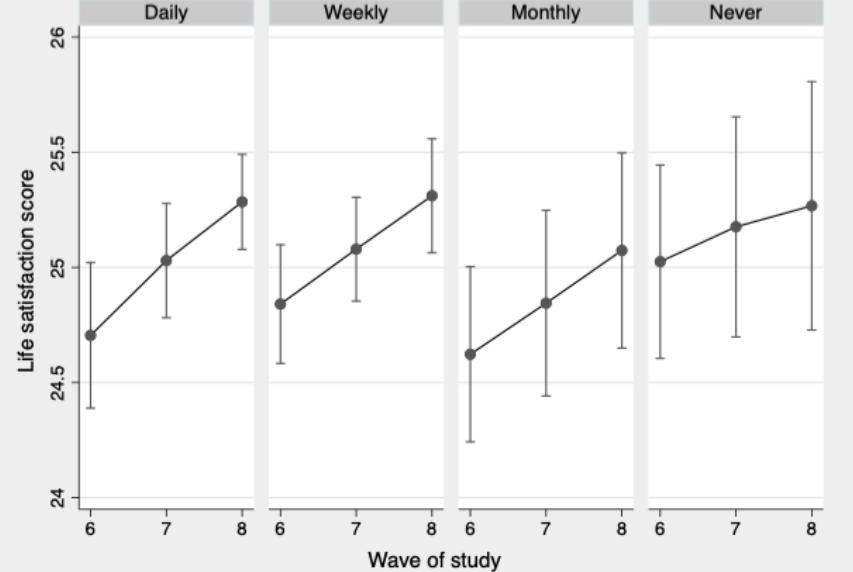
Figure 1. Predicted life satisfaction score by wave of study and frequency of internet usage from fixed effects model. Model adjusted for time-varying frequency of internet use, age, age square, working status, couple status, and health